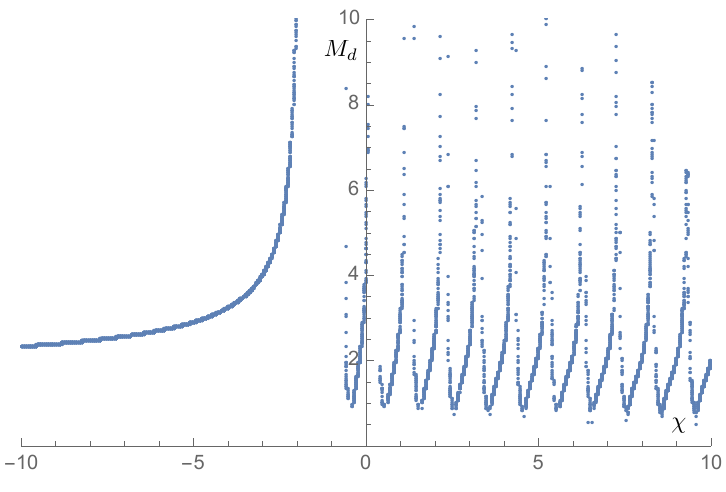
Figure 6 . A map of the (cid:12)t value of M